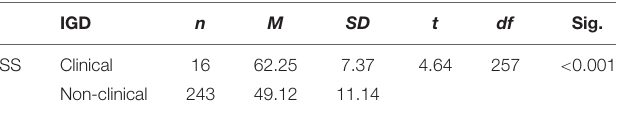
TABLE 6 | Means, standard deviations, and t -test for equality of means of SS scores according to clinical and non-clinical internet gaming disorder (IGD) scores. IGD n